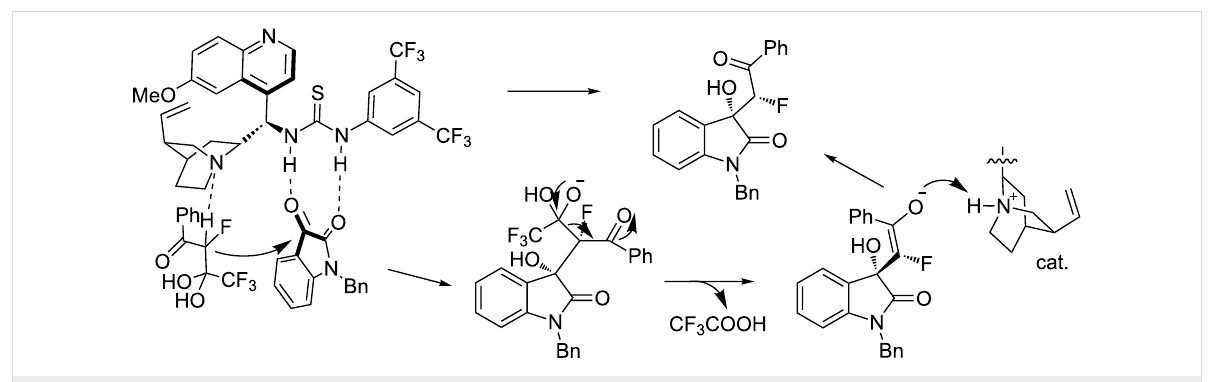
Scheme 29: Plausible mechanism proposed for the asymmetric aldol